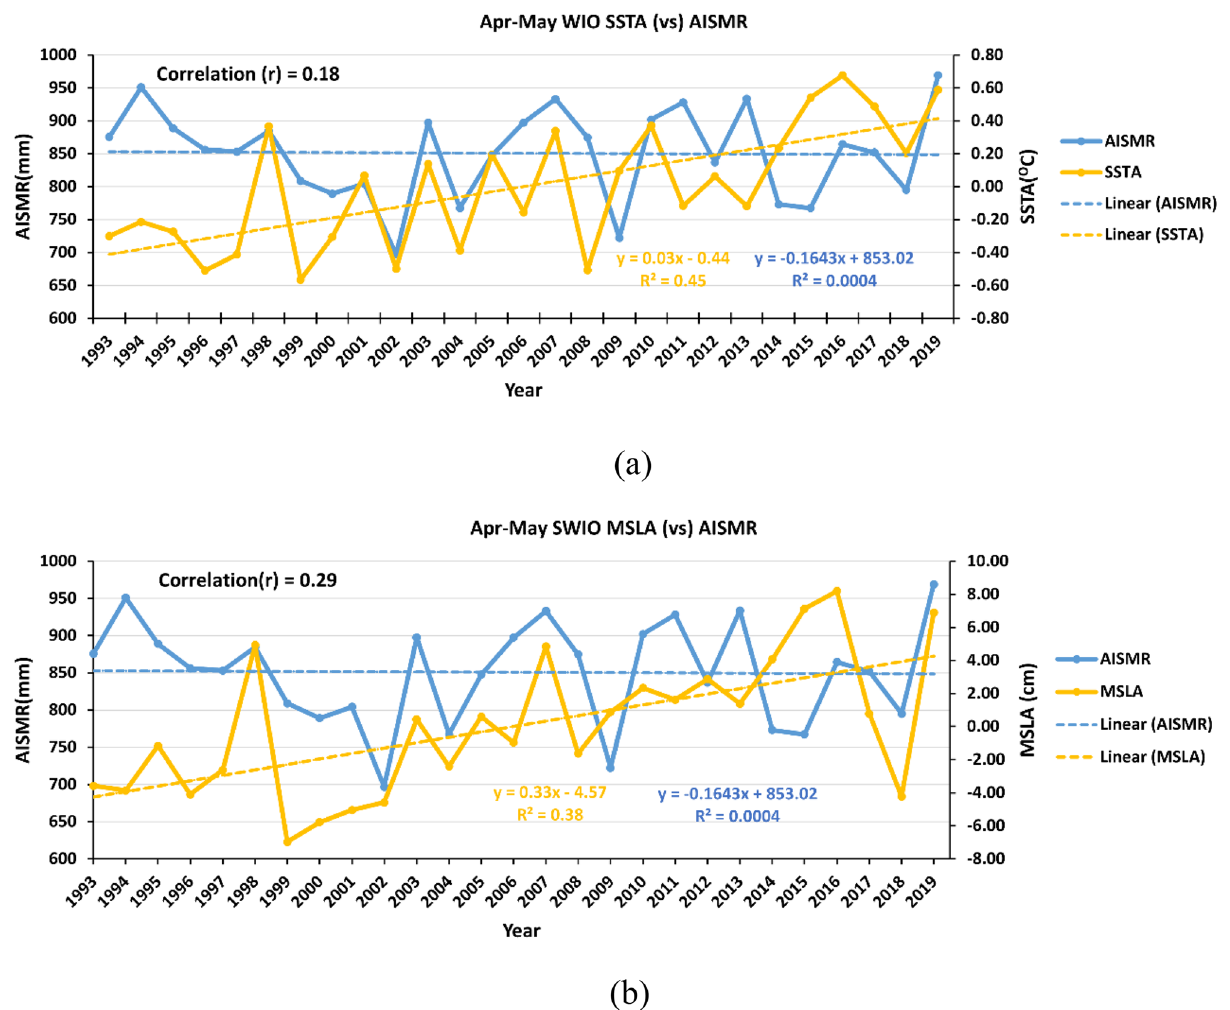
Figure 17. Time series of AISMR and SWIO ( a ) Apr–May SSTA, and ( b ) Apr–May MSLA during 1993–2019. The figure is generated using Microsoft